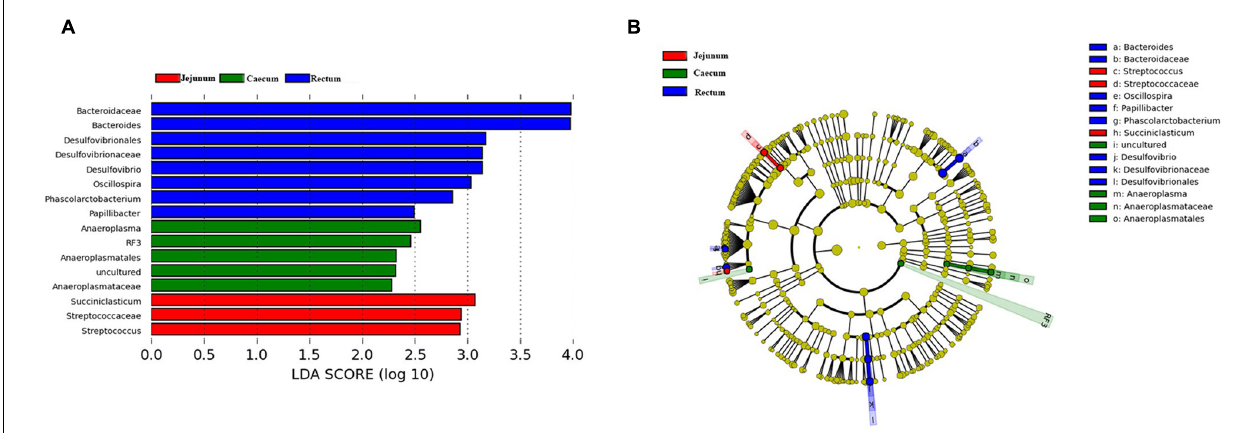
FIGURE 5 | Bacterial taxa significantly differentiated between the jejunum, caecum, and rectum samples identified by linear discriminant analysis effect size (LEfSe) using the default parameters. (A) Histogram of the LDA scores computed for bacterial taxa differentially abundant among different groups. (B) Bacterial taxa that were differentially abundant in different groups visualized using a